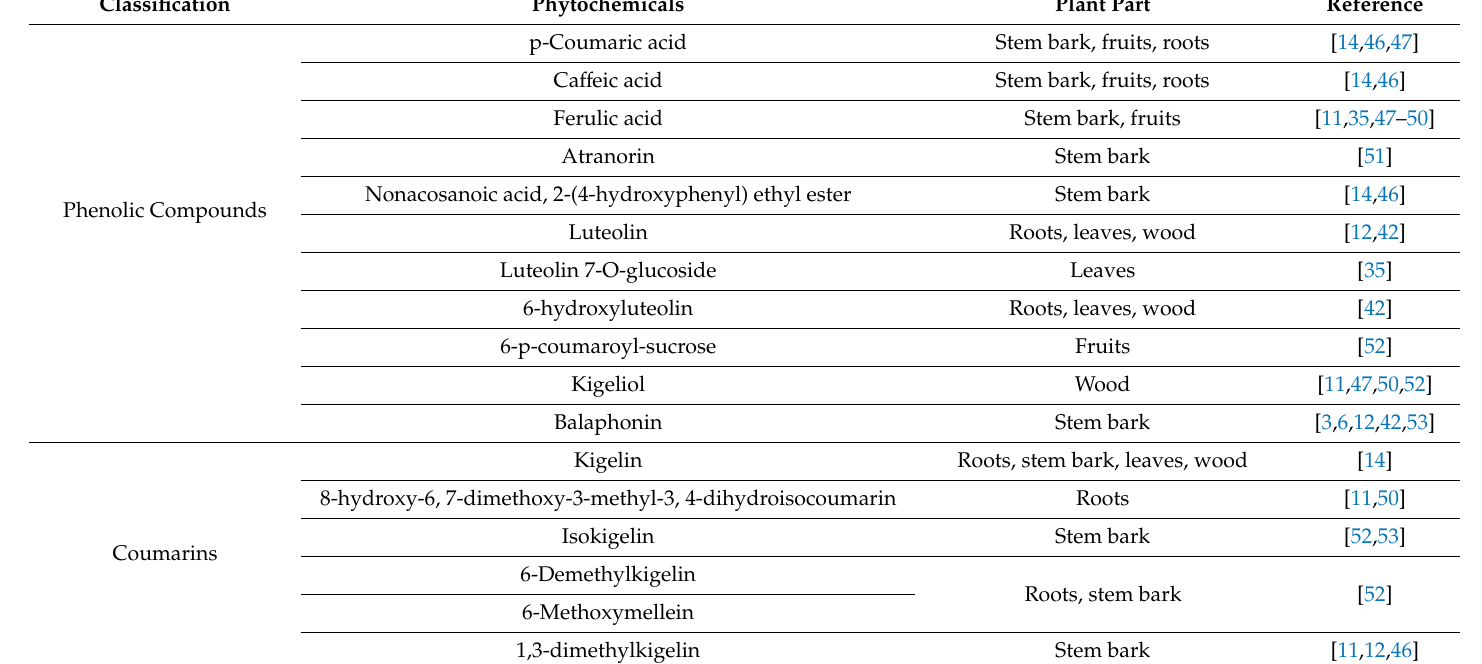
Table 2. Phytochemicals in Kigelia africana (Lam.) Benth. responsible for its pharmacological